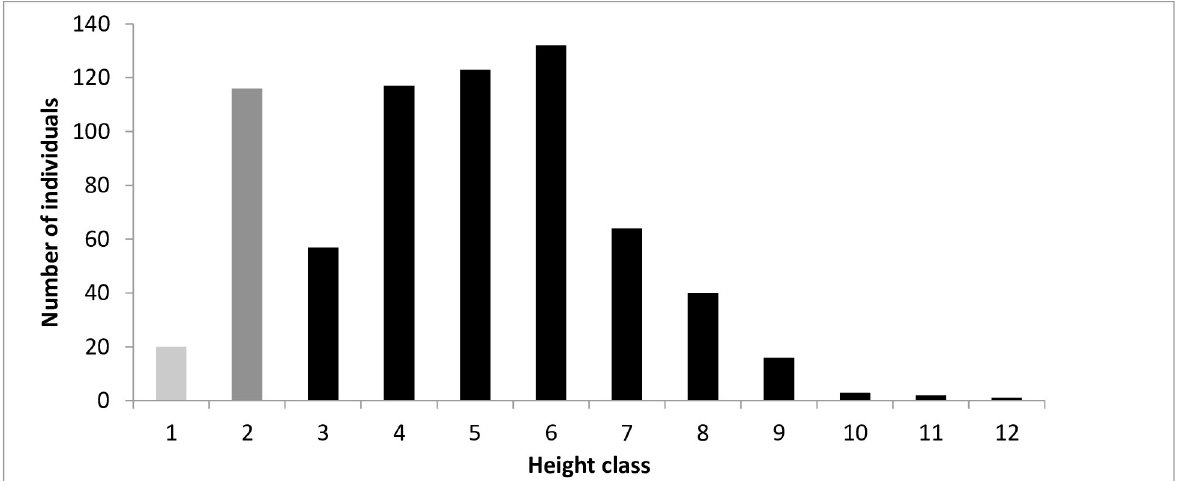
Fig 2. Height class distribution of O . europaea subsp. cuspidata in Hugumburda dry Afromontane forest in northern Ethiopia (1 < 0.3; 2 = 0.3–1.3; 3 = 1.4–2.3; 4 = 2.4–3.3; 5 = 3.4–4.3; 6 = 4.4–5.3; 7 = 5.4–6.3; 8 = 6.4–7.3; 9 = 7.4–8.3; 10 = 8.4–9.3; 11 = 9.4–10.3; 12 = > 10.3 m). Seedlings, light grey bar; saplings, dark grey bar; and adult trees, black bars.